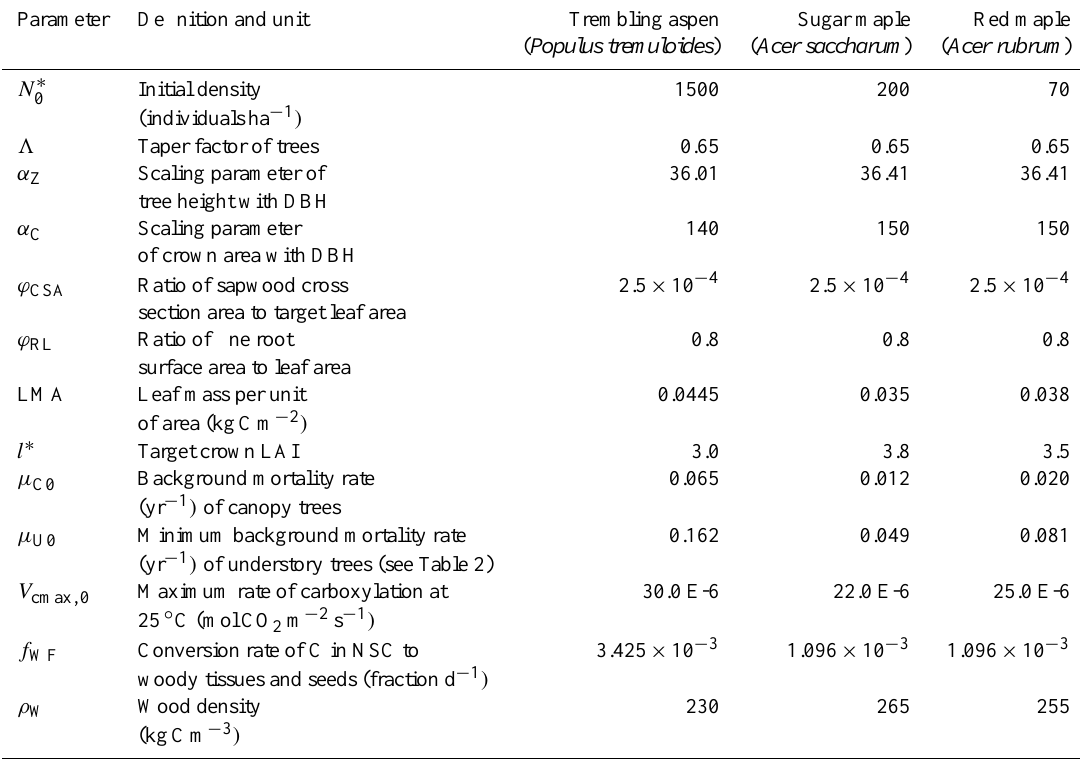
Table 1. Parameter values for the three tree species in the LM3-PPA simulations presented in Figs. 2–7. Parameter Definition and unit Trembling aspen Sugar maple Red maple